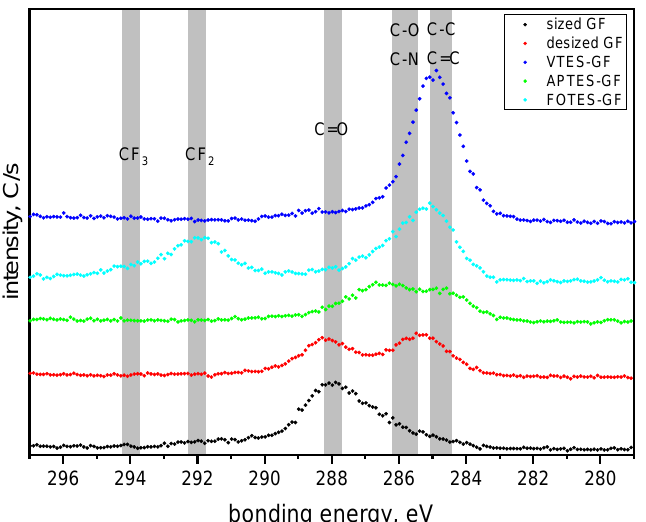
Figure 4. High resolution C 1s spectra of the glass fiber surface prior to and after desizing (acidic and basic piranha treatment) and subsequent modification with functional organo-silanes.